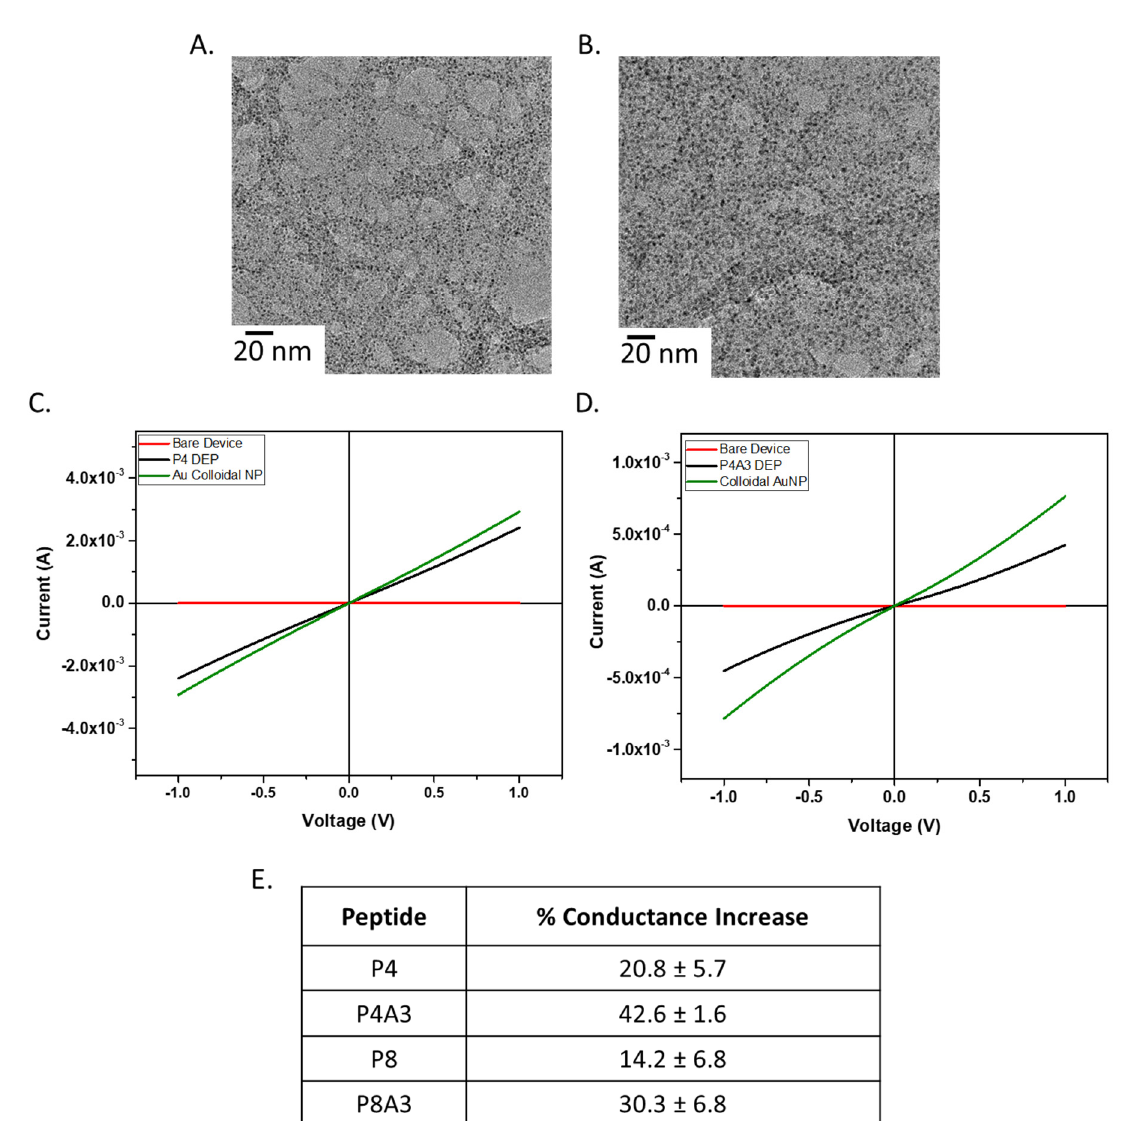
Figure 4. ( A-B ) HiPCO CNTs dispersed by peptide solutions were used to decorate 2 nm AuNPs with HiPCO CNTs (TEM) (( A ): P4, ( B ): P4-A3). ( C-D ) IV measurements from bare surface (red), peptide (( C ): P4, ( D ): P4A3) + CNT (black) and peptide + CNT + colloidal AuNPs (green). ( E ) Conductance increased after addition of AuNP confirming successful AuNP decoration on CNT by fusion peptides.